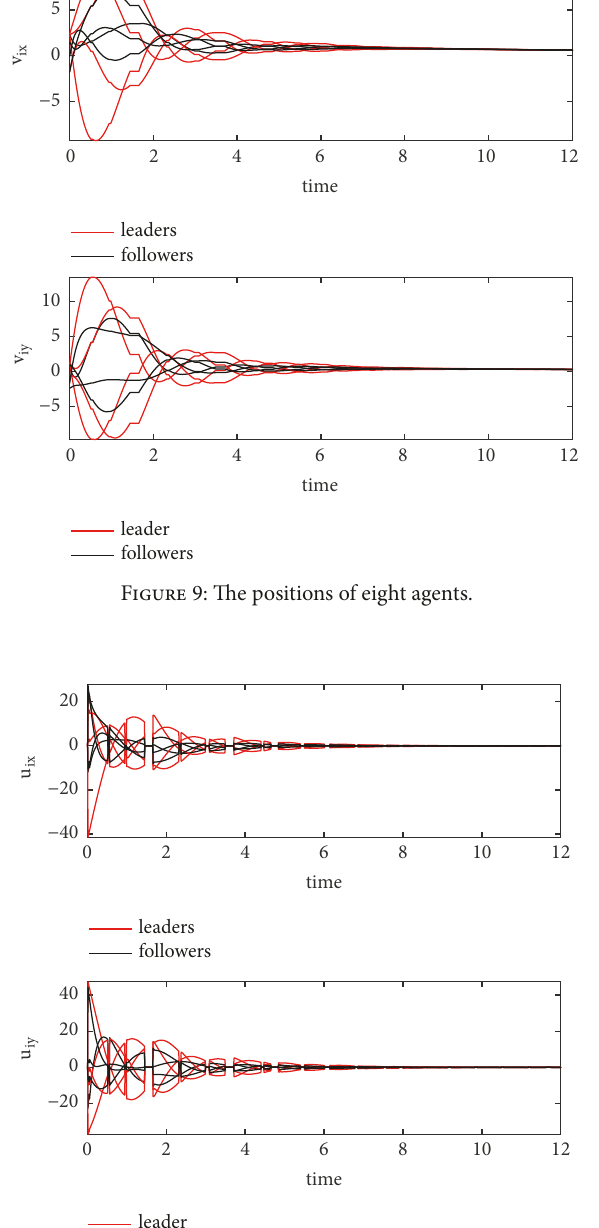
Figure 10: The inputs of eight